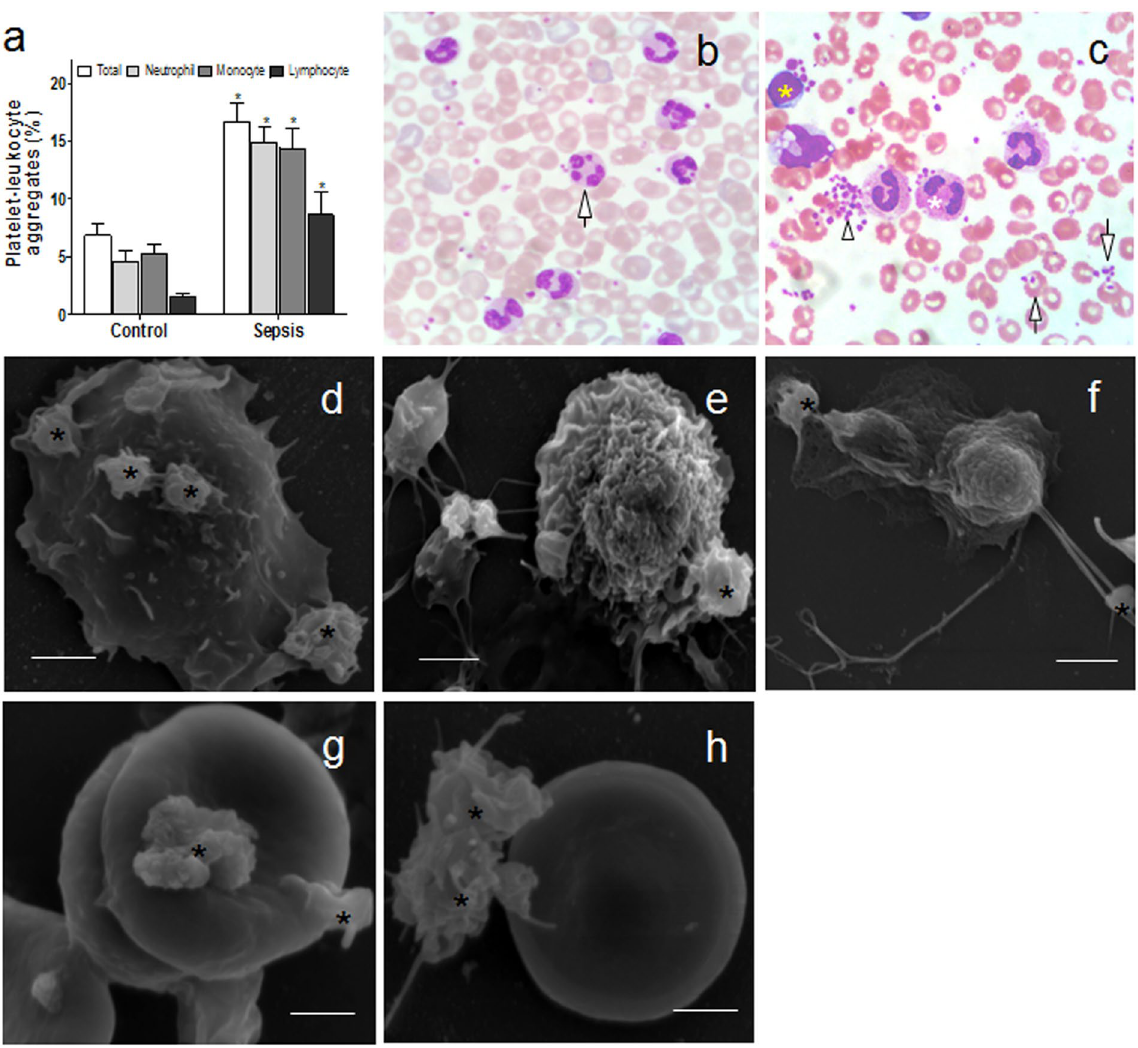
Figure 2. Platelets form heterotypic aggregates with blood cells in circulation. ( a ) The percentage of platelet- leukocyte aggregates (PLA) in healthy controls (n = 27) and patients (n = 27) were measured by flow cytometry. Data represents mean ± SD. * P < 0.05 versus control. ( b , c ) Blood smears (n = 15) stained with Hematoxylin- Eosin were observed using a light microscope and typical images of PLA were shown. ( b ) PLA (arrow) in healthy control; and ( c ) several platelets were seen adhered to the neutrophil ( * white), lymphocyte ( * yellow), and erythrocytes (arrows) in the patient sample. Platelet-platelet aggregation (arrowhead) was also observed. Magnification 40x. Scanning electron microscope images (n = 15): ( d , e ) activated platelets ( * ) anchored on a leukocyte extending pseudopods; ( f ) platelet-leukocyte aggregate releasing extracellular trap-like structures from the nucleus. Single ( g ) and small clusters ( h ) of activated platelets ( * ) were seen with extended pseudopods or their whole bodies on the membrane of erythrocytes. Bars represent 2 μ